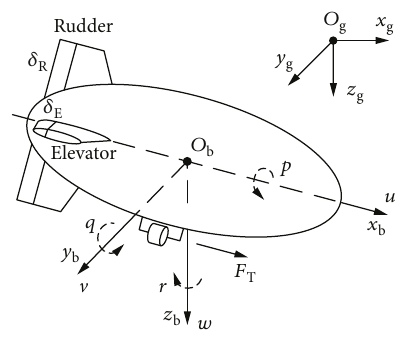
Figure 1: Coordinate frame of the